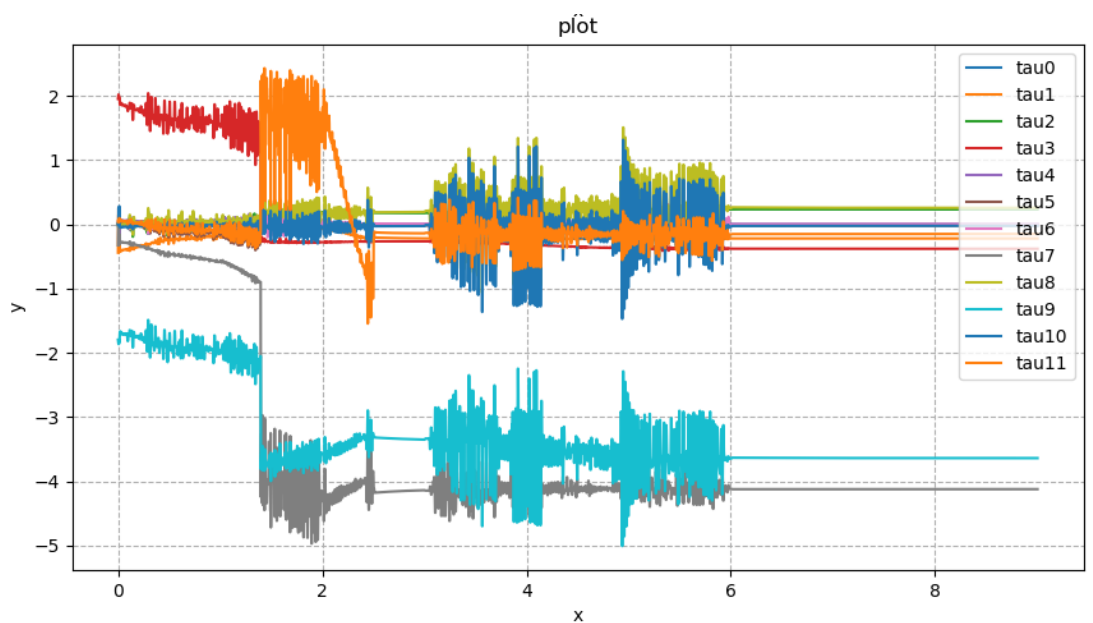
12 of 31 Figure 7. A Drake visualization of Roban standing on a single leg. The green symbols represent the plantar contact force of the robot. In Figure 8, the direction of x represents the planned time, and the direction of y represents the specific torque. The subsequent spring compensation experiments were carried out in Drake’s simulation software. This simulation phase was not repeated in the physical experiment. The compensation coefficient in Table 3 was used for the experi- ments. The CSV file containing the robot’s torque feed forward, which was obtained from